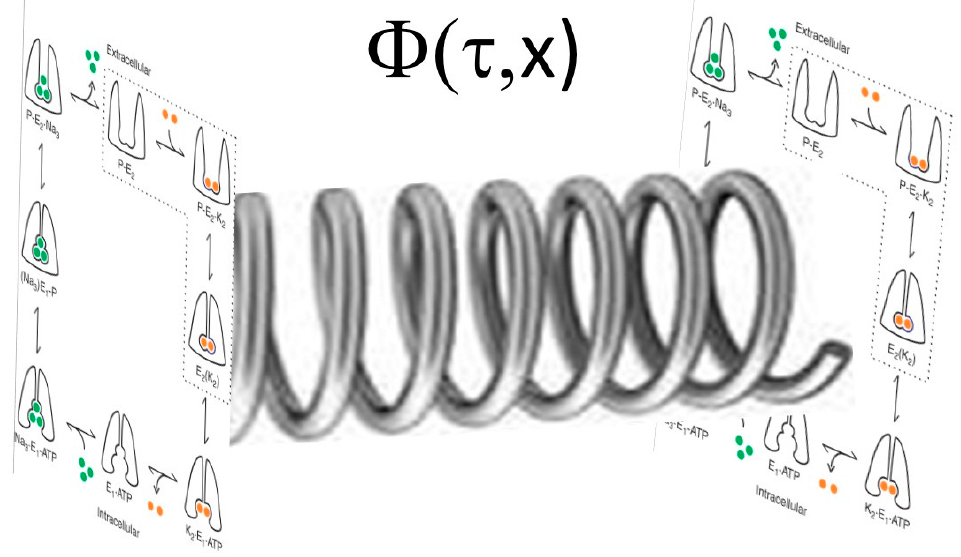
Figure 2. Post-Albers model of Na/K-ATPase shown as a wave function in the complex plane with transitions between the E1 and E2 states with different phosphorylation steps shown.